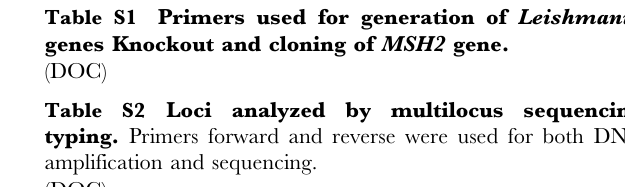
Figure S2 MSH2 knockout cells grow similarly to wild- type cells but have increased alkylation tolerance. (A) Growth of promastigotes in vitro . Parasites were inoculated at 2 6 105 cells/ml and then they were counted every 24 hours. The mean of three independent experiments are indicated. L. infantum N 263 ( D ), double replacement clone ) and double replacement clone (Li263 D MSH2::HYG:BLA) ( complemented with MSH2 gene (Li263 D MSH2::HYG:BLA) [pSP72 a PUR a - MSH2 ] ( & ). (B) Promastigotes parasites were grown in increased concentrations of MNNG (Nmethyl-N 9 -nitro- N-nitrosoniguanidine) and the EC 50 values were determined after 72 hours of growth. The mean of three independent experiments are indicated with a statistical significance observed by Student’s t- test (p , 0.05) (*). Table S1 Primers used for generation of Leishmania genes Knockout and cloning of MSH2 gene. Table S2 Loci analyzed by multilocus sequencing typing. Primers forward and reverse were used for both DNA amplification and sequencing. Table S3 Loci analyzed by multilocus sequencing typing genes. Primers forward and reverse were used for both DNA amplification and sequencing (Table S2). The natural polymor- phisms between L. major and L. infantum enabled mapping the size of exchanged DNA by sequencing. The SNPs found in the hybrid 263 (1) of Figure 2 are listed by their respective position in the gene. Table S4 Loci analyzed by multilocus sequencing typing genes. Primers forward and reverse were used for both DNA amplification and sequencing (Table S2). The natural polymor- phisms between L. major and L. infantum enabled mapping the size of exchanged DNA by sequencing. The SNPs found in the hybrid JPCM5 (1) of Figure 2 are listed by their respective position in the gene. Table S5 Loci analyzed by multilocus sequencing typing genes. Primers forward and reverse were used for both DNA amplification and sequencing (Table S2). The natural polymor- phisms between L. major and L. infantum enabled mapping the size of exchanged DNA by sequencing. The SNPs found in the hybrid JPCM5 (2) of Figure 2 are listed by their respective position in the gene. Table S6 Loci analyzed by multilocus sequencing typing genes. Primers forward and reverse were used for both DNA amplification and sequencing (Table S2). The natural polymor- phisms between L. major and L. infantum enabled mapping the size of exchanged DNA by sequencing. The SNPs found in the hybrid L. infantum 263 of Figure 3D are listed by their respective position in the gene. Table S7 Loci analyzed by multilocus sequencing typing genes. Primers forward and reverse were used for both DNA amplification and sequencing (Table S2). The natural